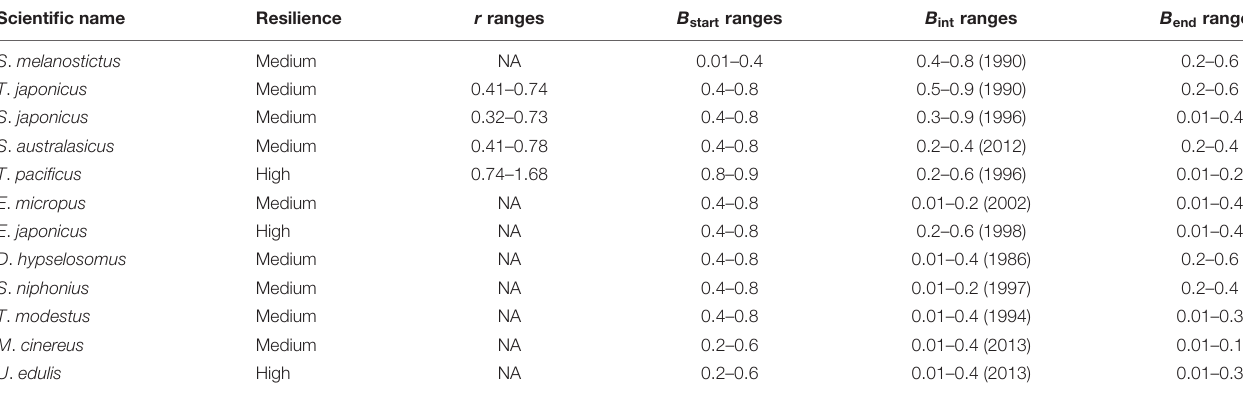
TABLE 2 | Prior ranges used for CMSY and BSM; the resilience ranges were from FishBase (Froese and Pauly,